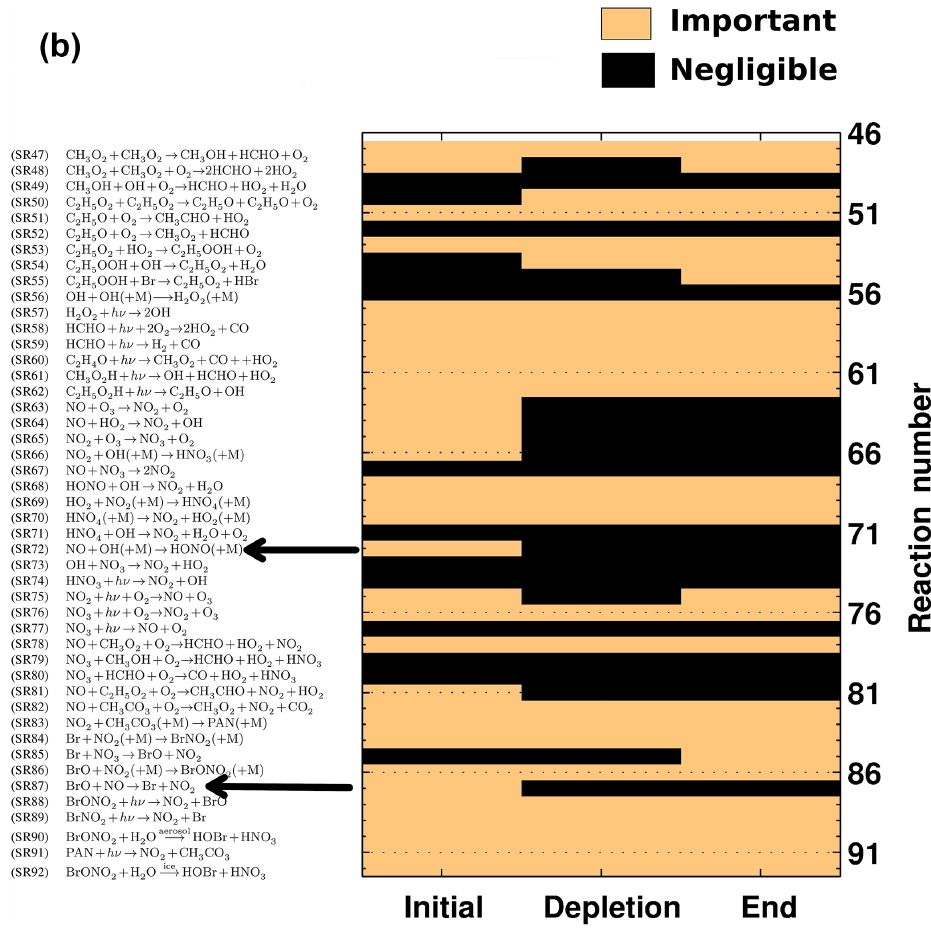
Figure 6. The importance of each reaction in the original reaction mechanism within different time periods, for (a) Reactions (SR1)–(SR46) and (b) Reactions (SR47)–(SR92). Yellow contour denotes that this reaction is important through this time period, while black contour represents that this reaction is identified as insignificant during this time stage.